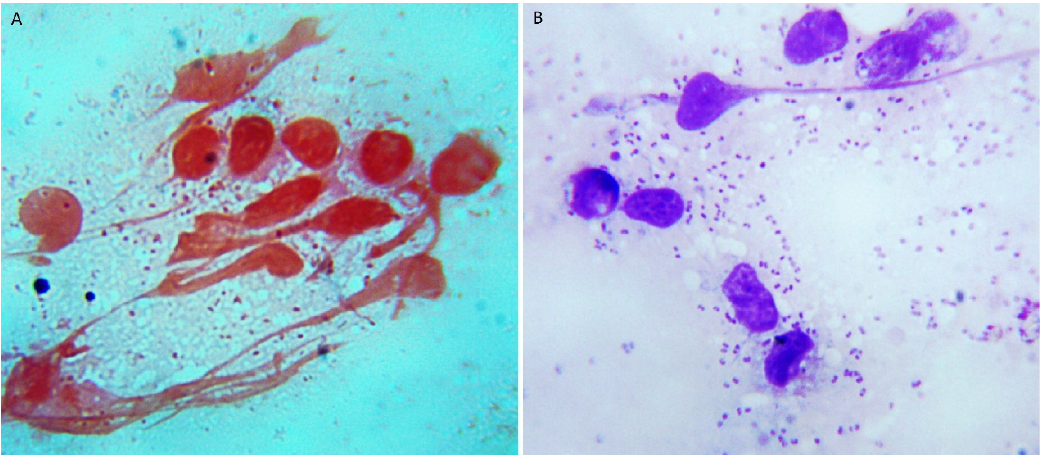
Figure 7. Microscopic examination of bacteria in lung smears of infected mice. ( A ) Gram stain; ( B ) Wright stain. ( B ) Wright